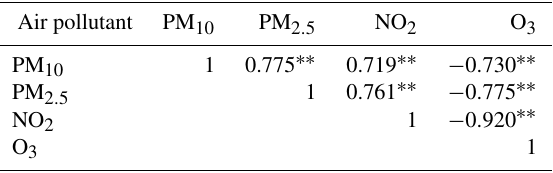
Table 3. Pearson correlation coefficients (PCCs) among the esti- mated concentrations of ambient PM 10 , PM 2 . 5 , NO 2 and O 3